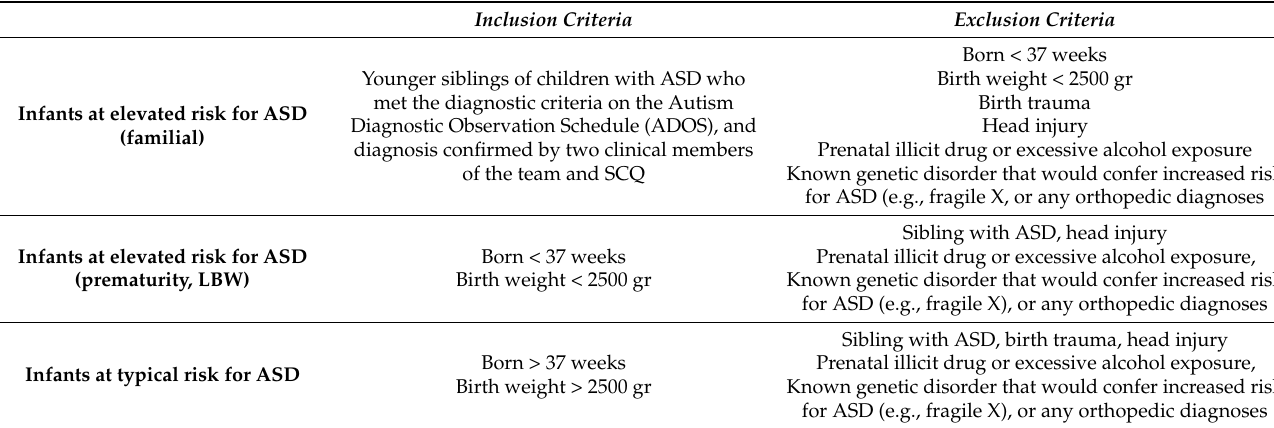
Table 2. Inclusion/Exclusion Criteria.